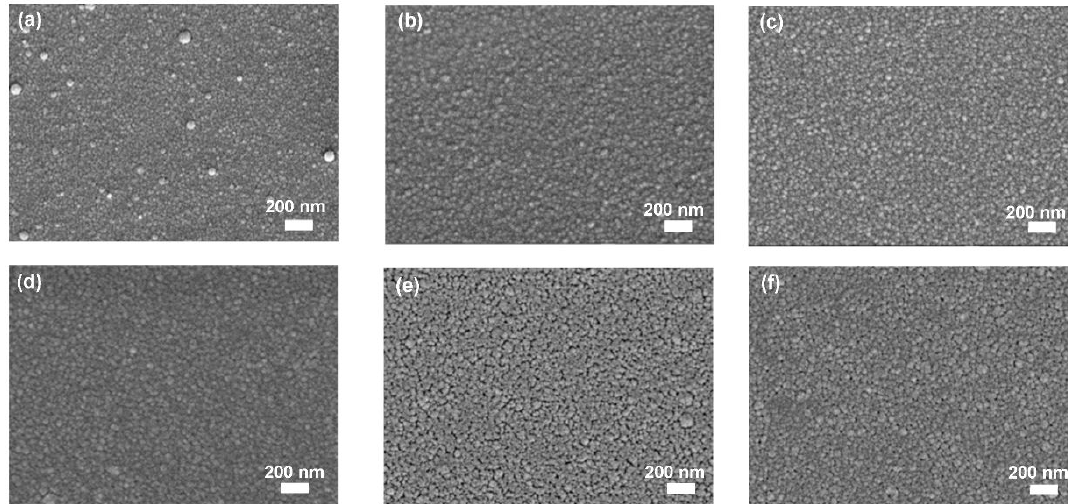
Figure 15. SEM micrographs of ZnGa 2 O 4 thin film samples at different annealing temperatures of ( a ) as-deposited, ( b ) 500, ( c ) 600, ( d ) 700, ( e ) 800 and ( f ) 900 °C [74].